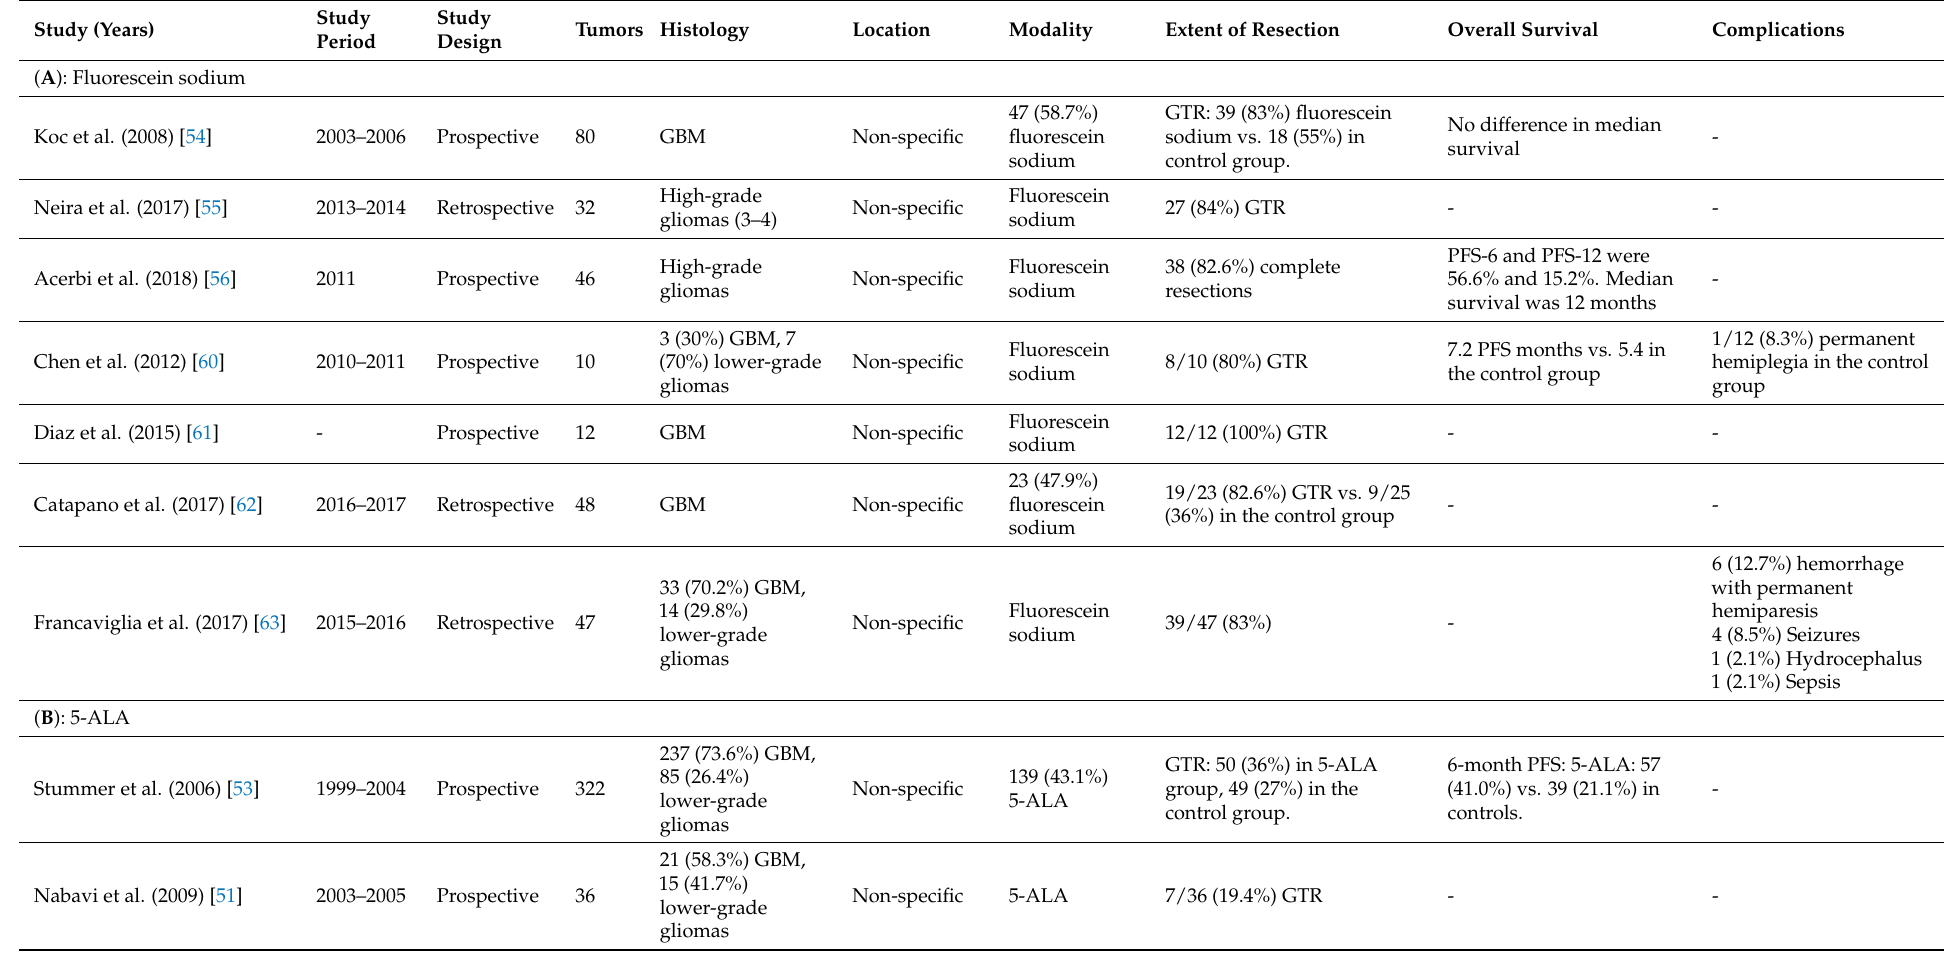
Table 3. ( A – C ) Studies investigating the role of intraoperative 5-ALA and sodium fluorescein in improving the extent of resection: ( A ) fluorescein sodium; ( B ) 5-ALA; ( C ) fluorescein sodium and